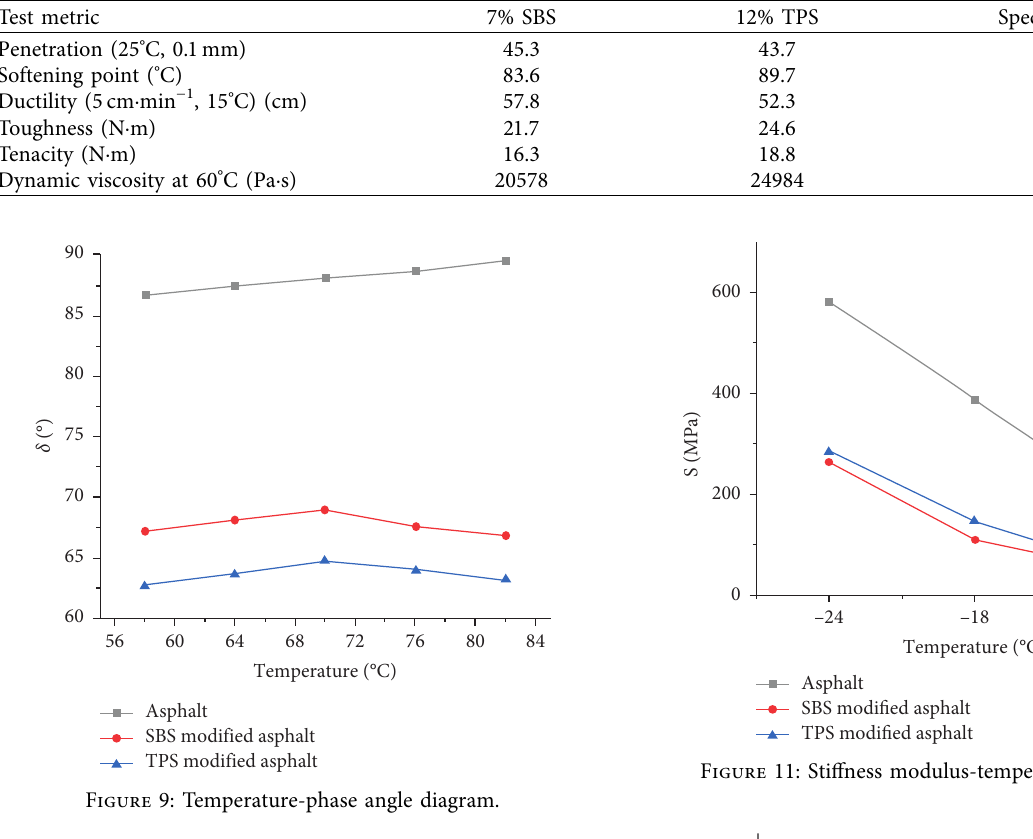
Table 11: Experimental results of modified asphalt.